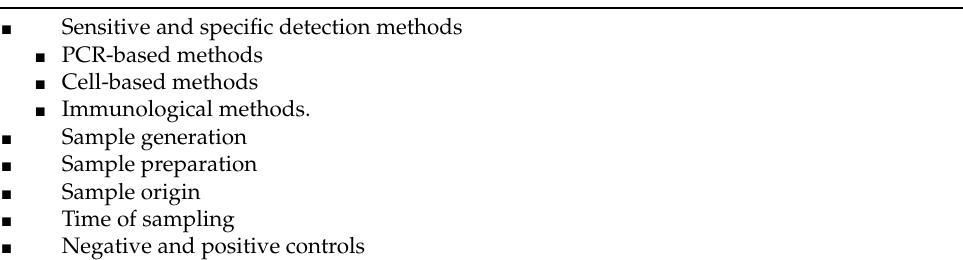
Table 7. Components of the detection systems